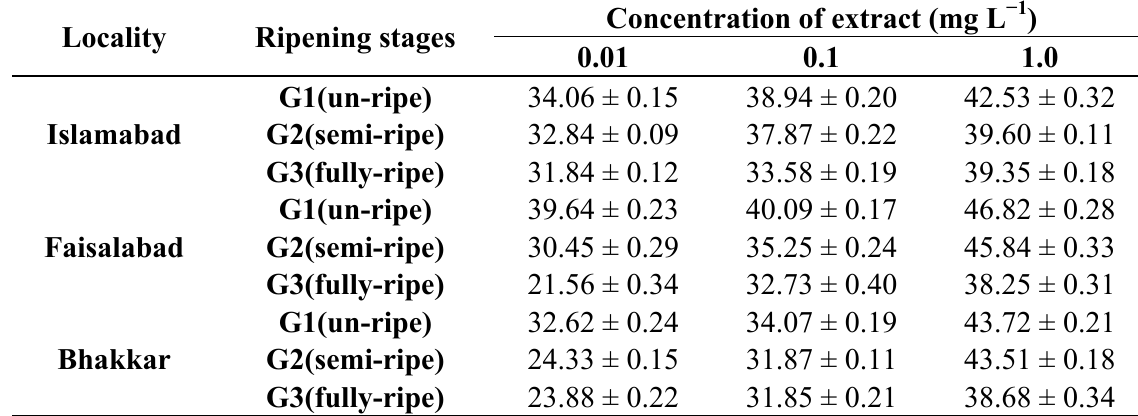
Table 4. DPPH radical scavenging activity of extracts from guava fruit at different stages of ripening.